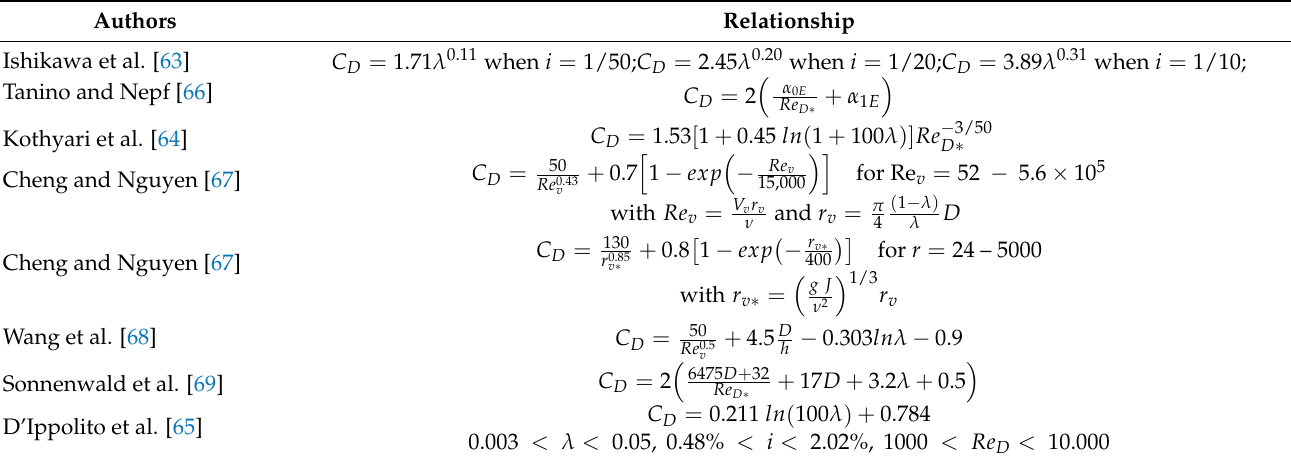
Table 1. Equations for estimating the drag coefficient C D in case of arrays of emergent cylinders. Authors